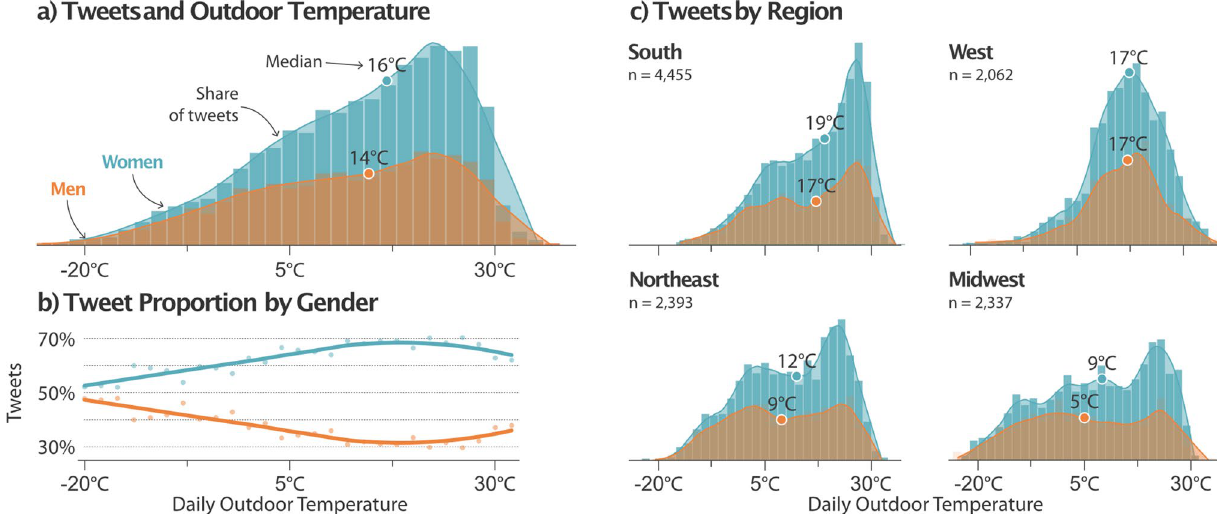
Figure 3. Cold office tweets and outdoor temperature. The distribution of cold office tweets and average daily outdoor temperature (2 °C bin width) where the tweet was sent. ( a ) Distribution of tweets for women and men across the range of outdoor temperatures. There are more tweets from women at all temperatures. The median outdoor temperature is shown inset and is lower for men than women, indicating that a greater proportion of tweets from women are in warmer outdoor temperatures than men. ( b ) The proportion of tweets from balanced samples (repeated 100 times) of binned outdoor temperatures. The likelihood of women tweeting about cold discomfort increases with warmer temperatures. ( c ) Tweet distribution of men and women grouped by US Census region. Southern states had the most tweets, which likely reflects the excessive cooling of offices in part from the dehumidification requirements of those